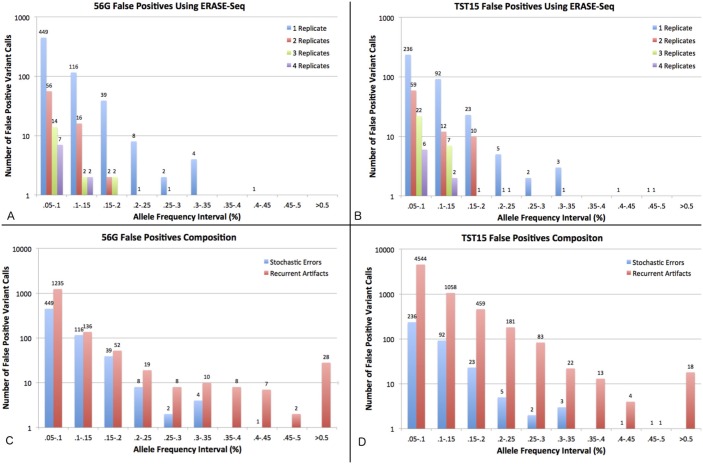
False positive composition.(A,B) The number of false positive calls in 0.05% allele frequency intervals is shown for ERASE-Seq using 1, 2, 3, and 4 replicates for the amplicon panels 56G and TST15. (C,D) The number of false positives using standard intra-sample variant calling metrics (base-quality, strand-bias and read-depth filters) are shown in 0.05% allele frequency intervals for 56G and TST15. They are further divided into recurrent artifacts and stochastic errors. Stochastic errors are those called in single replicate ERASE-Seq and recurrent artifacts are those eliminated in single replicate ERASE-Seq based on the background model.